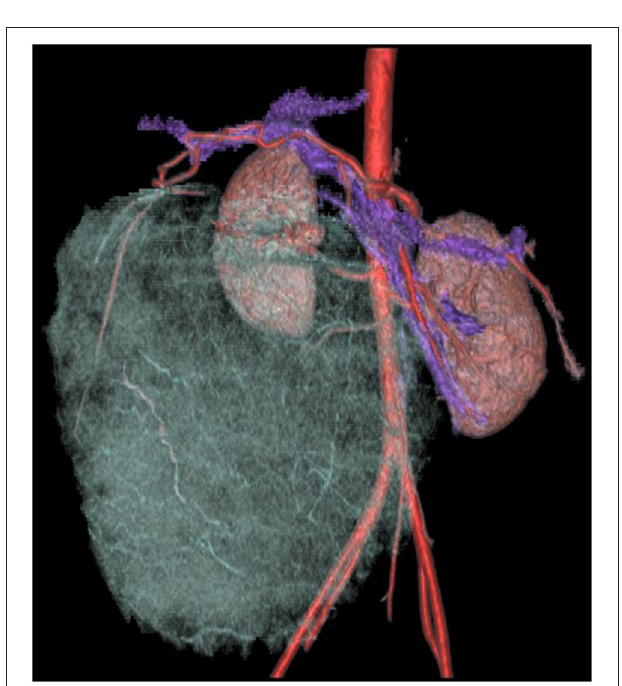
FIGURE 2 | Enhanced CT of progressive enhancement of the solid part of the lesion in the portal venous phase, the lesion closely related to the liver, and the abdominopelvic fluid